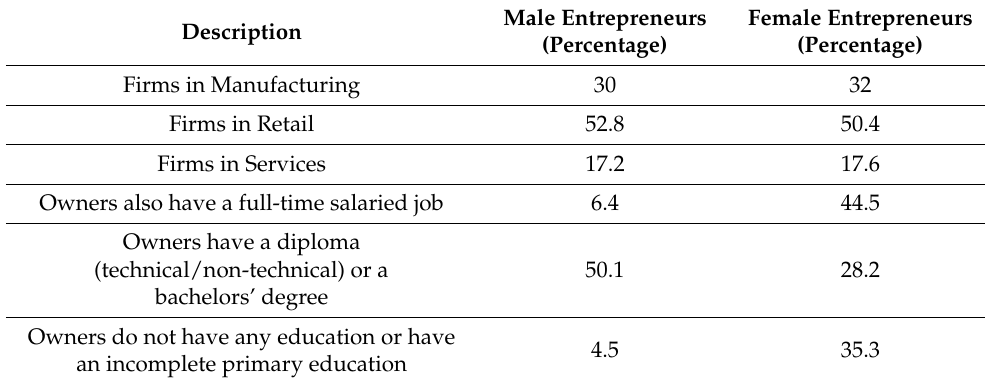
Table 5. Other salient features of the